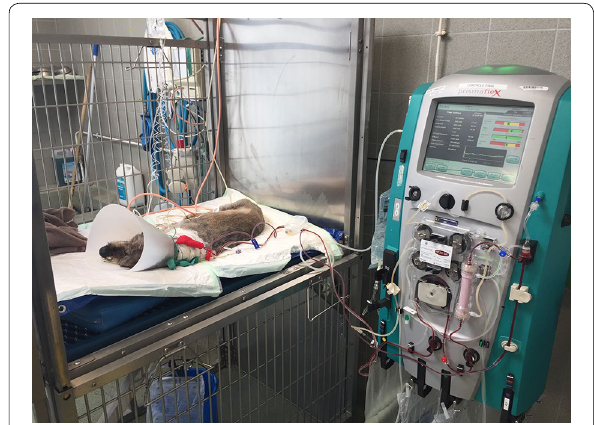
Fig. 1 Example of a dog treated for multiple organ failure secondary to leptospirosis infection in the veterinary intensive care